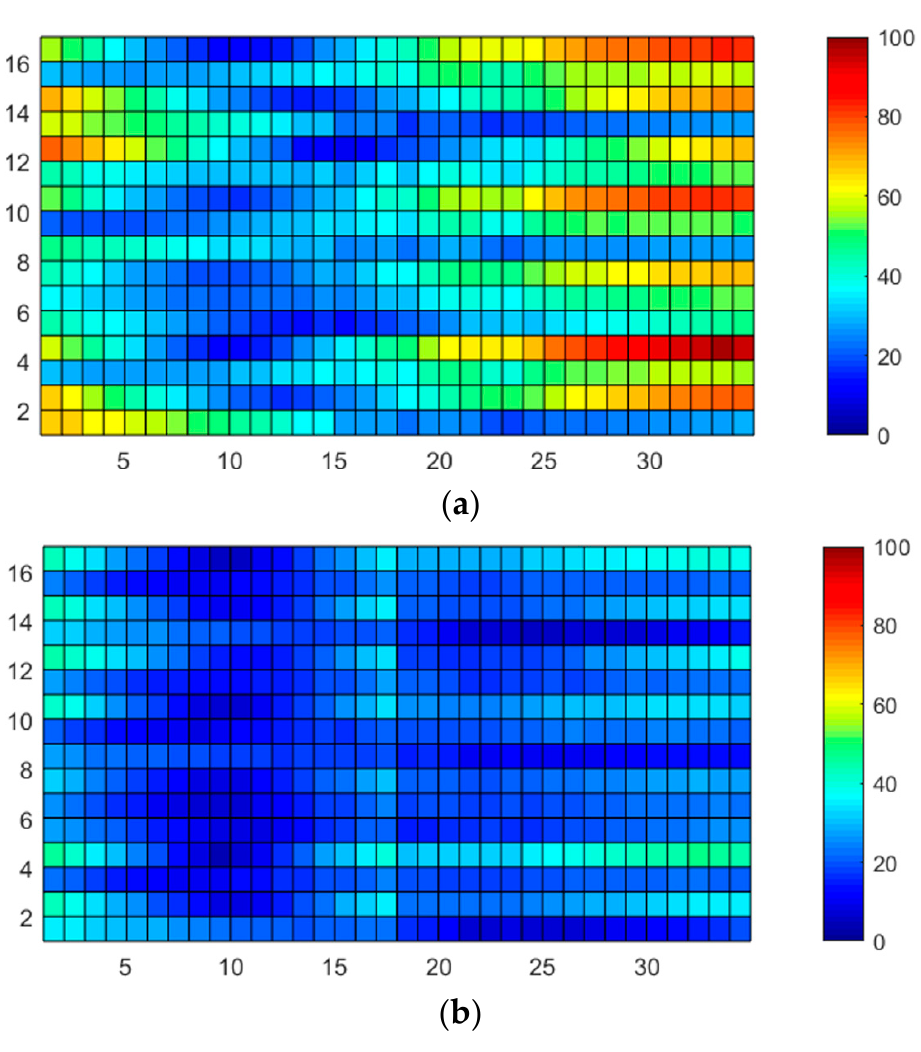
Figure 19. Figure 19. RMS noise-jitter values of TSP raw data for ( a ) single RX-line reference and ( b ) MRDS scheme.